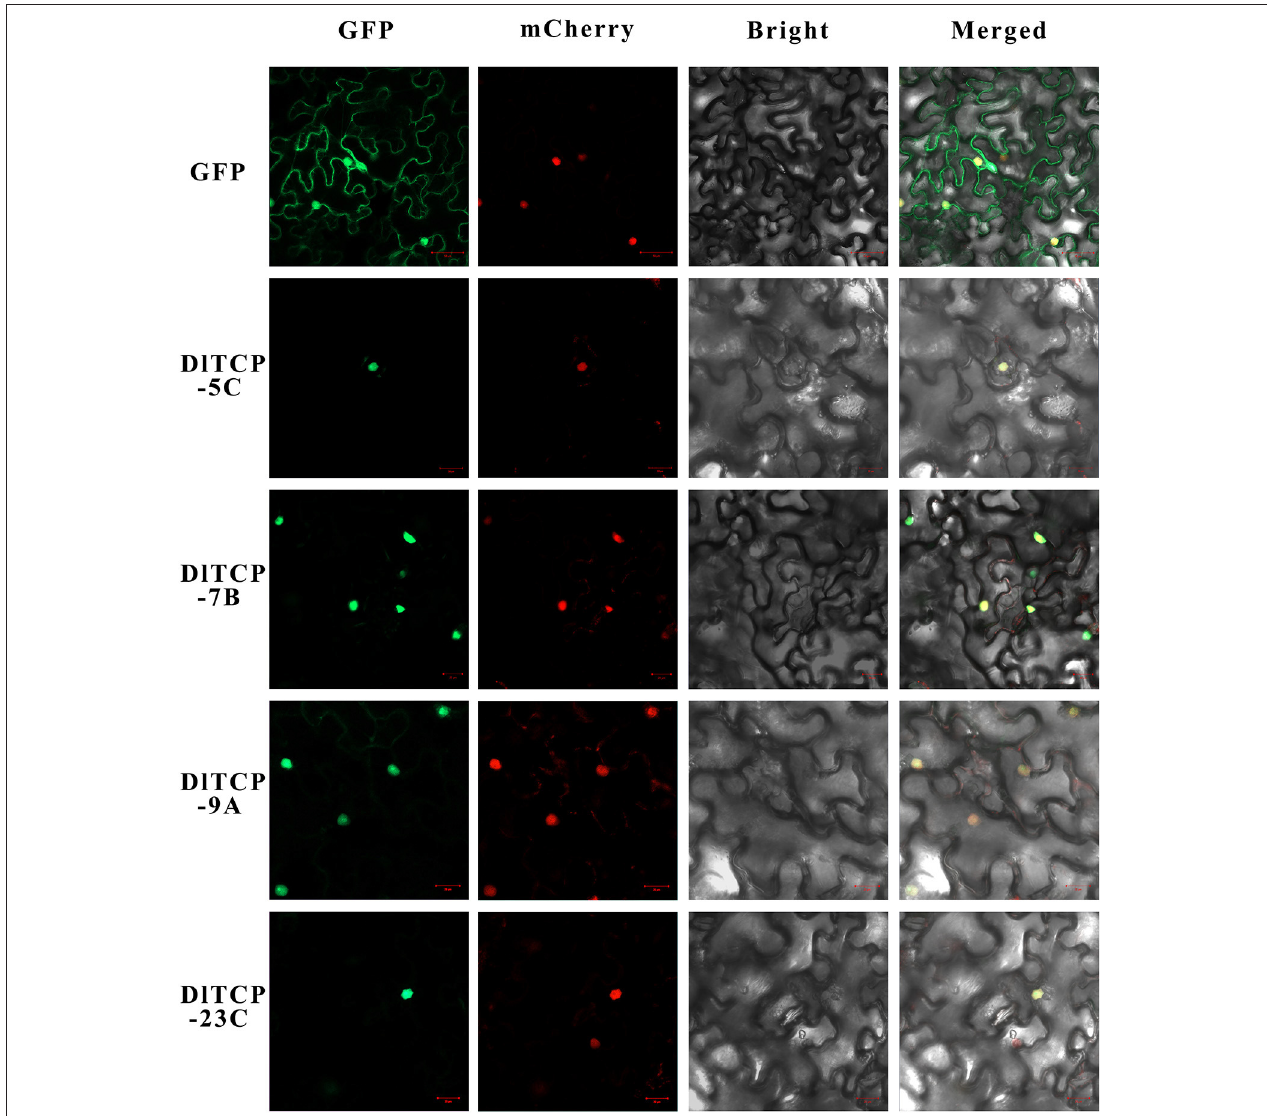
FIGURE 9 | Subcellular localization of four mGFP-fused TCP proteins in Ma bamboo. The four candidate TCP proteins (DlTCP5-C, DlTCP7-B, DlTCP9-A, and DlTCP23-C) and GFP as a control were transiently expressed in Nicotiana benthamiana leaves and observed under a fluorescence microscope. The nucleus was visualized with mCherry-labeled nuclear